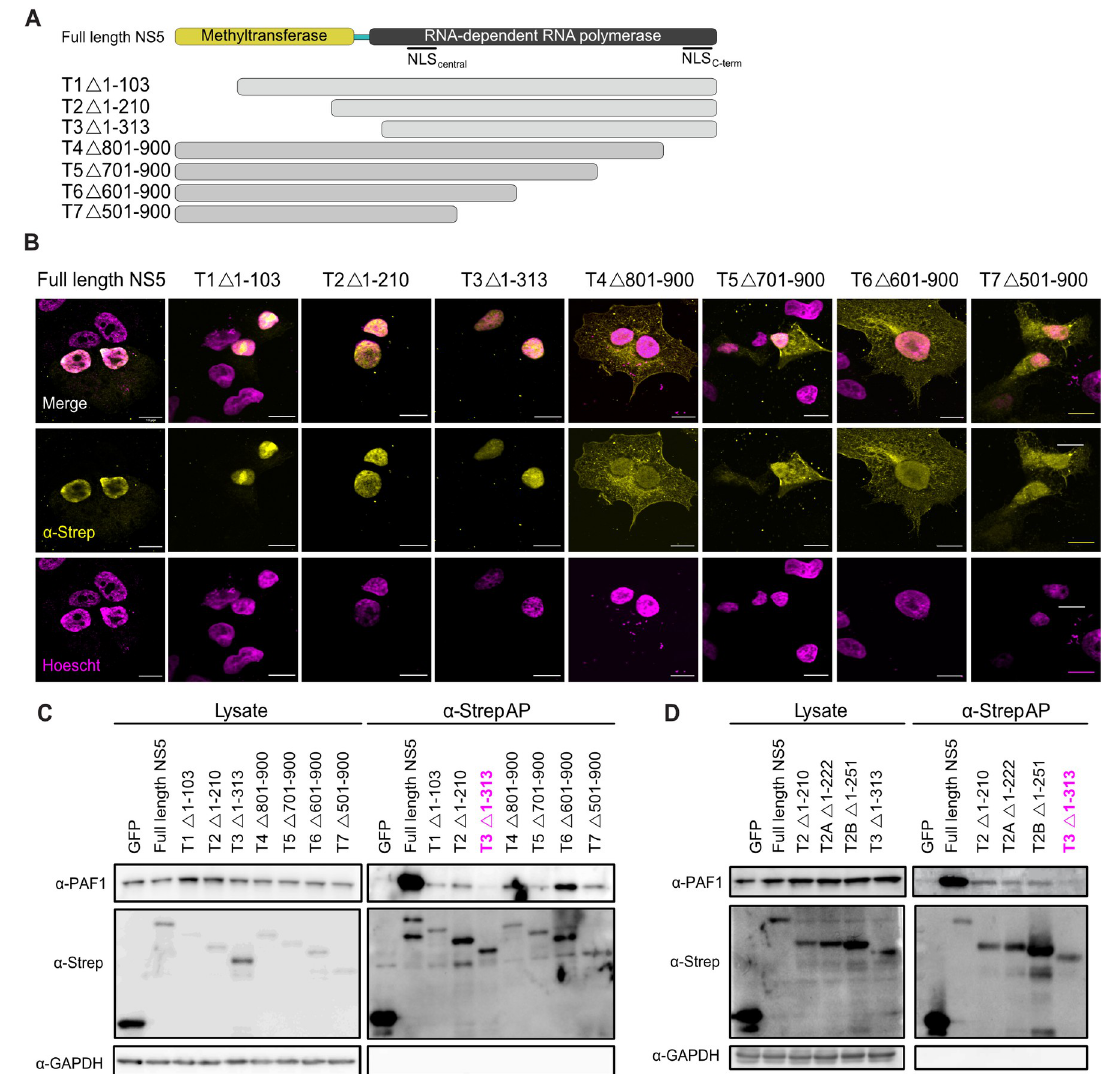
Fig 4. A C-terminal region of MTase domain is responsible for interaction with PAF1C. (A) NS5 truncations constructed to test NS5-PAF1 interaction. Each truncation corresponds to ~100 amino acid deletions from the N- (T1, T2, T3) or C-terminus (T4, T5, T6, T7) of NS5. (B) Subcellular localization of 2xStrep II tagged truncations and NS5 full-length (yellow) and colocalization with PAF1 (cyan) were determined by immunostaining and confocal microscopy. Nuclei were stained with Hoechst (magenta). Scale bar represents 10 μ m. (C) The protein interaction between NS5 truncations and PAF1 were tested biochemically. Plasmids encoding NS5 truncations,